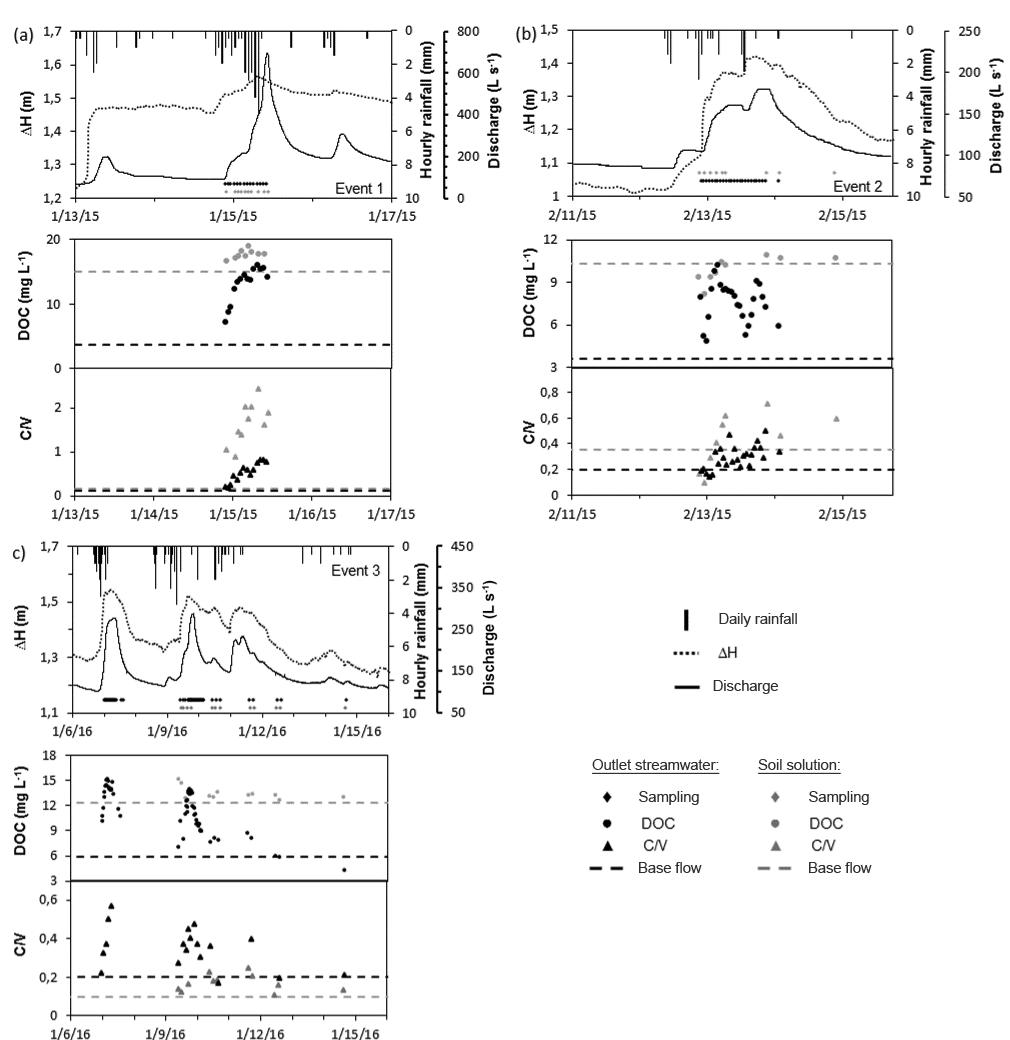
Figure 3. Hourly rainfall, discharge and (cid:49) H for events 1, 2 and 3. Evolution of DOC concentration and C / V in stream water and soil